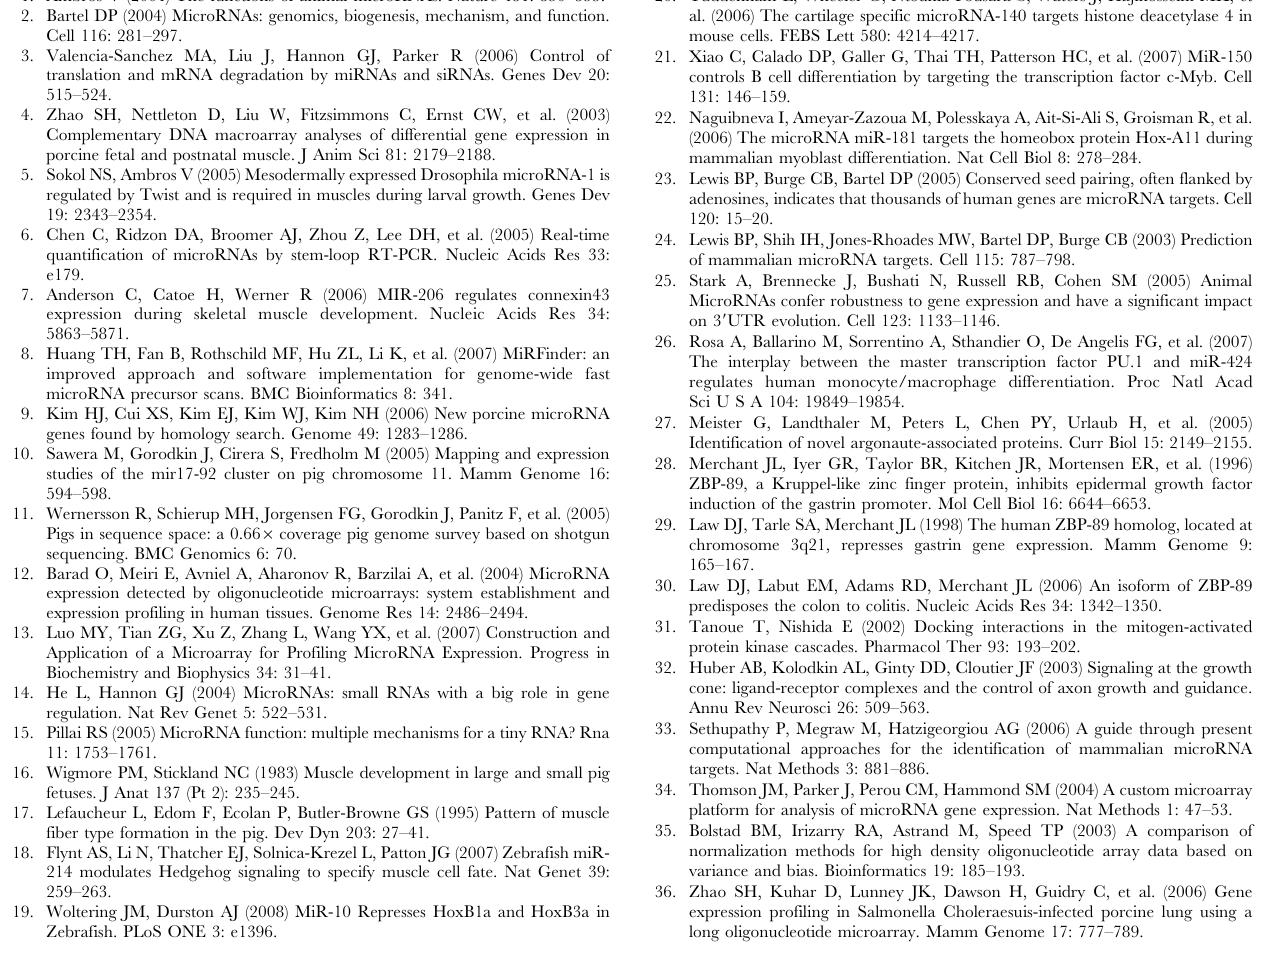
Found at: doi:10.1371/journal.pone.0003225.s009 (0.51 MB